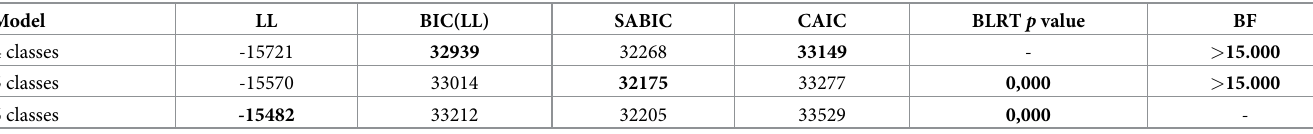
Table 2. Model fit